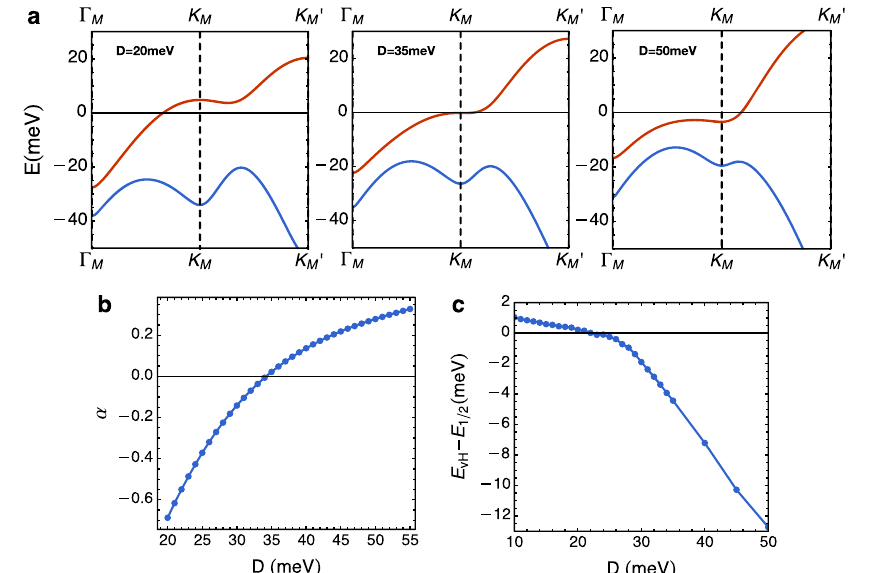
Fig. 4 Details of the moiré band structure. a A few examples of the band structure as function at different displacement fi elds. b The phenomenological parameter α as a function of the displacement fi eld obtained by fi tting the band structure near K M point. The critical displacement fi eld D c is ≅ 35 meV. c The energy distance between the van Hove singularity and half- fi ling Fermi level as a function of the displacement fi eld.